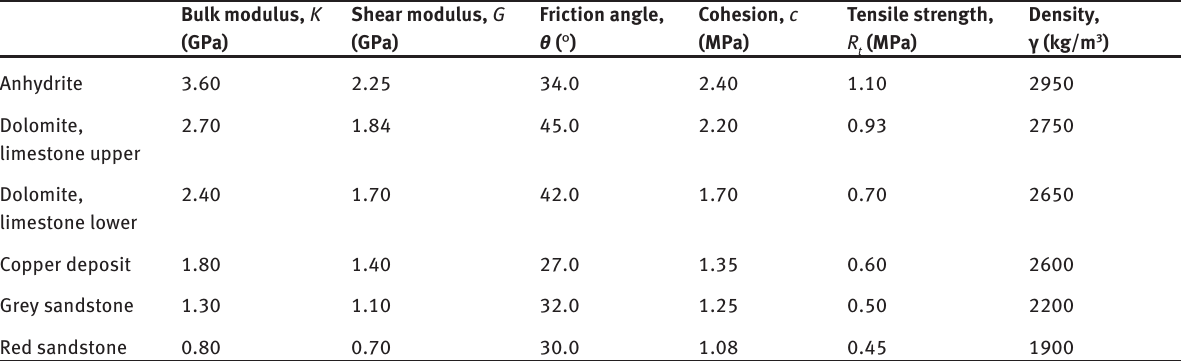
Table 4: Mechanical parameters of rock mass adopted for numerical modelling.